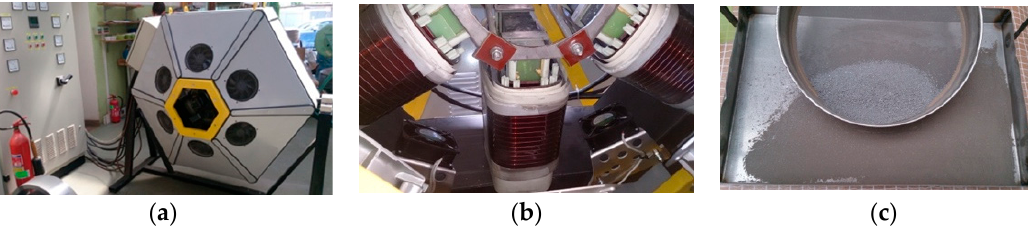
Figure 1. Electromagnetic mill system photos ( a ) housing; ( b ) electromagnetic field conductors; ( c ) final product manual classification.